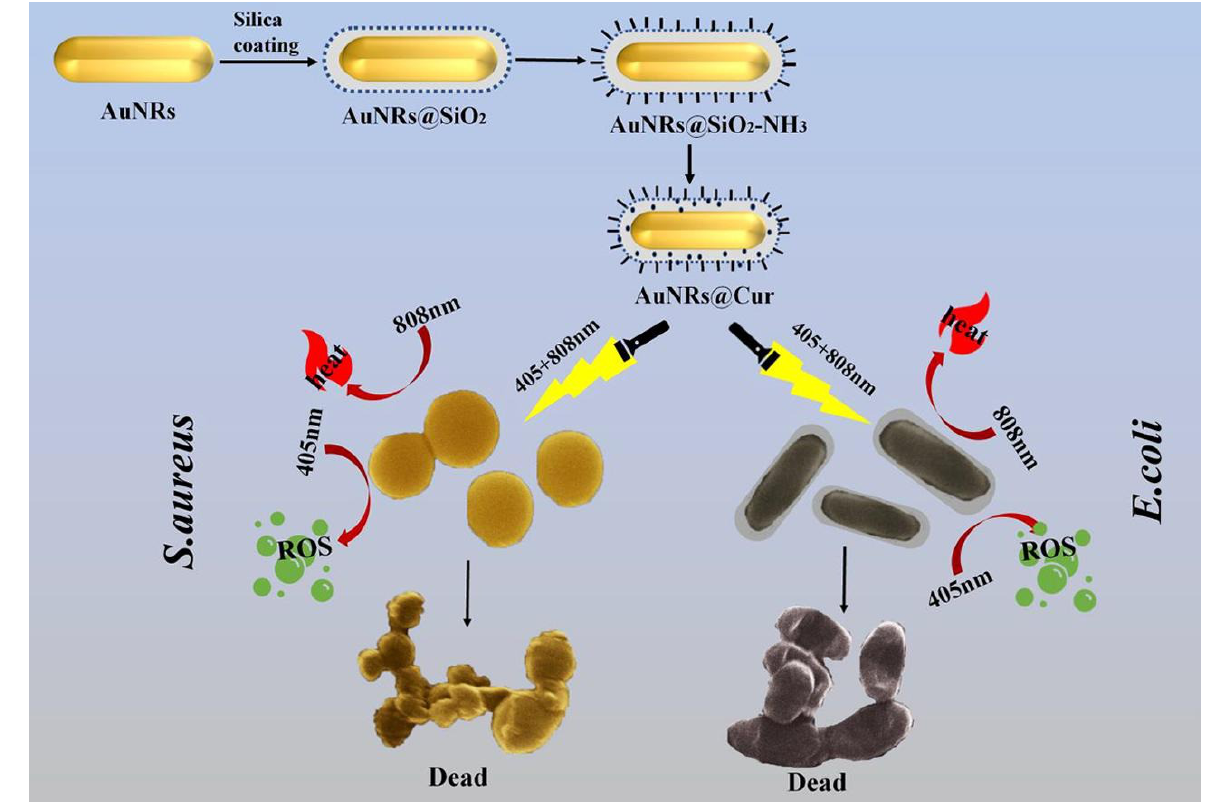
Figure 5. Schematic illustration of preparation and synergistic antibacterial activity of gold nanorods (Au NRs)@curcumin (Cur). Reproduced with permission from Ref. [82]. Copyright 2022 Elsevier.